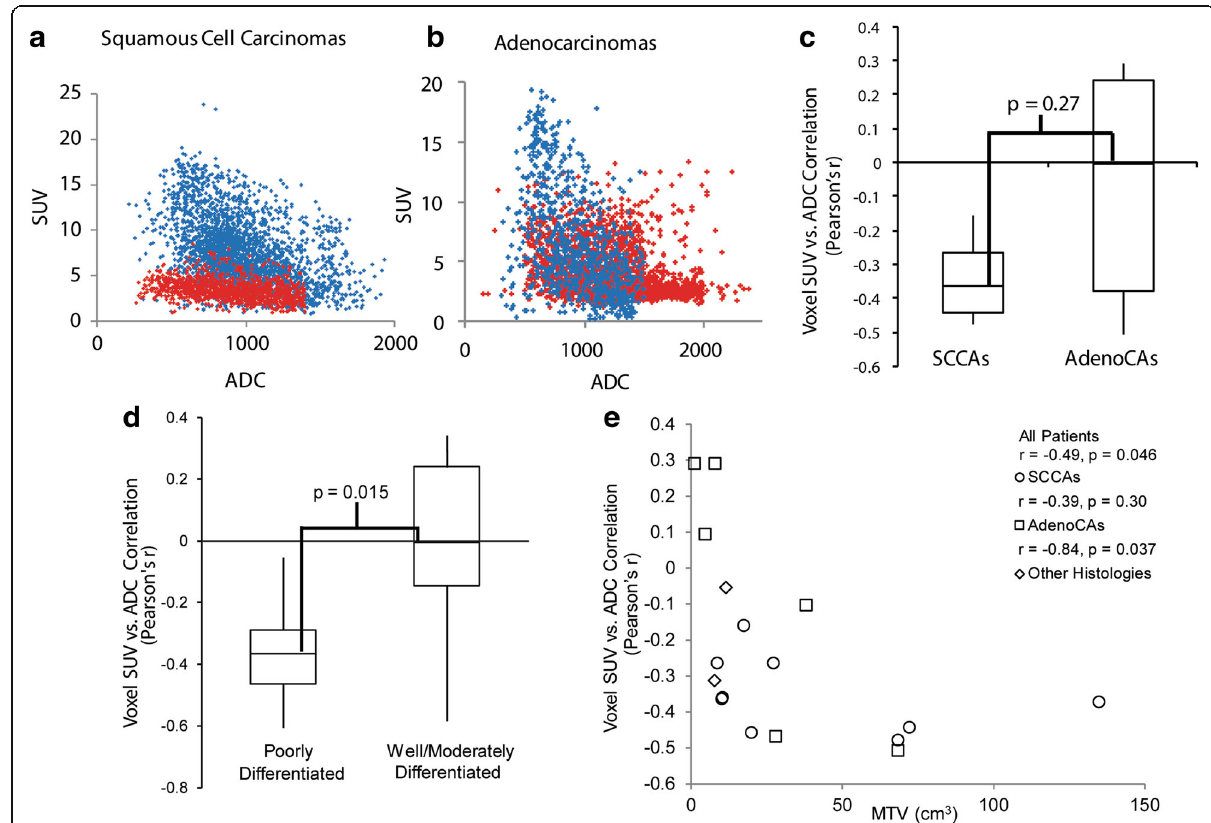
Fig. 3 The voxel ADC vs. SUV comparisons for all SCCA tumors ( a ) and all AdenoCA tumors ( b ). Each point represents a single voxel, and all voxels from all tumors are displayed together. For the SCCAs ( a ), in the majority of tumors, there is a steeper SUV vs. ADC slope (blue); for two tumors, the slope is not as steep, but there is still a correlation (red). For the AdenoCAs ( b ), one tumor has a steep SUV vs. ADC slope (blue), but voxels from the rest of the tumors are more erratically scattered (red). When the correlation between ADC and SUV, as measured by Pearson ’ s r , is compared between SCCAs and AdenoCAs, there is a consistent inverse correlation between these values in SCCAs, but not AdenoCAs ( c ). Poorly differentiated tumors have a significantly greater inverse correlation between voxel SUV and ADC compared to well/moderately differentiated tumors ( d ). The correlation between voxel SUV and ADC varies with MTV, though this relationship is primarily driven by the AdenoCAs ( e )